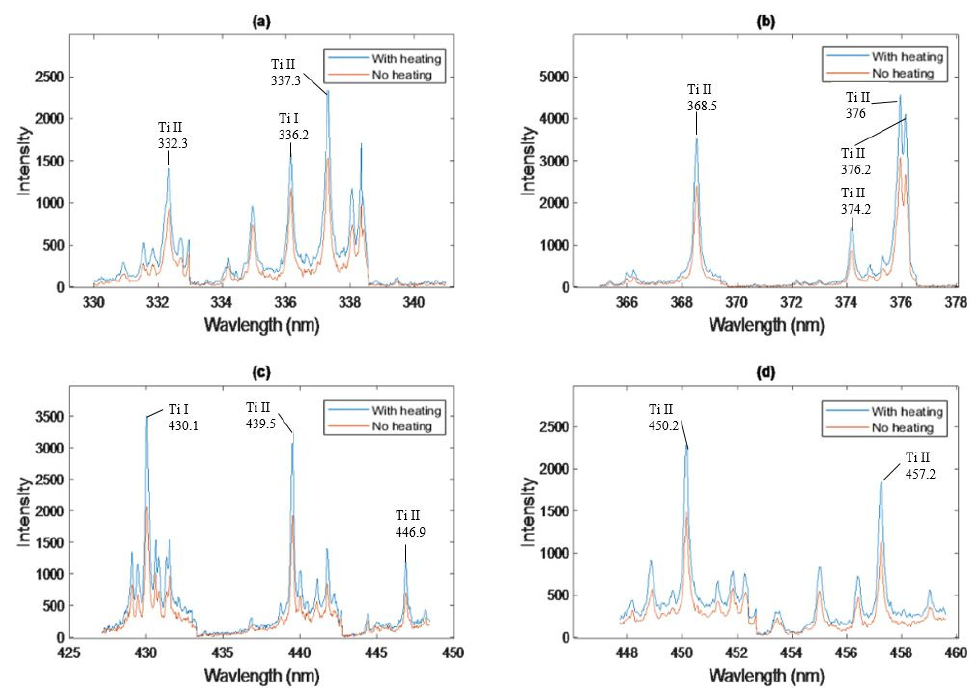
Figure 4. LIBS spectra of the Ti plasma with four different spectral regions with sample temperature of 100 °C and without sample temperature at a delay time of 12 µs and laser fluence of 23.3 J cm − 2 . ( a ) from the spectral range of 330–340 nm; ( b ) from the spectral range of 365–377 nm; ( c ) from the spectral range of 427–448 nm; ( d ) from the spectral range of 447–460 nm.